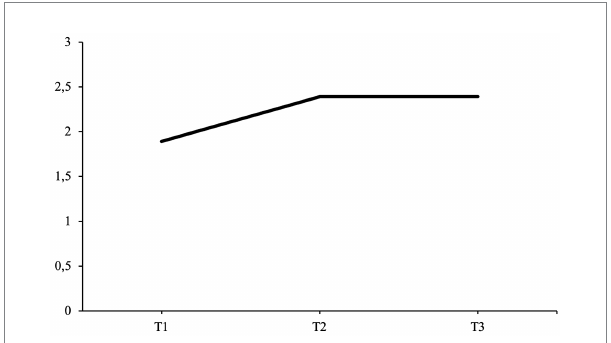
FIGURE 9 Average life story coherence scores at each interview time point.